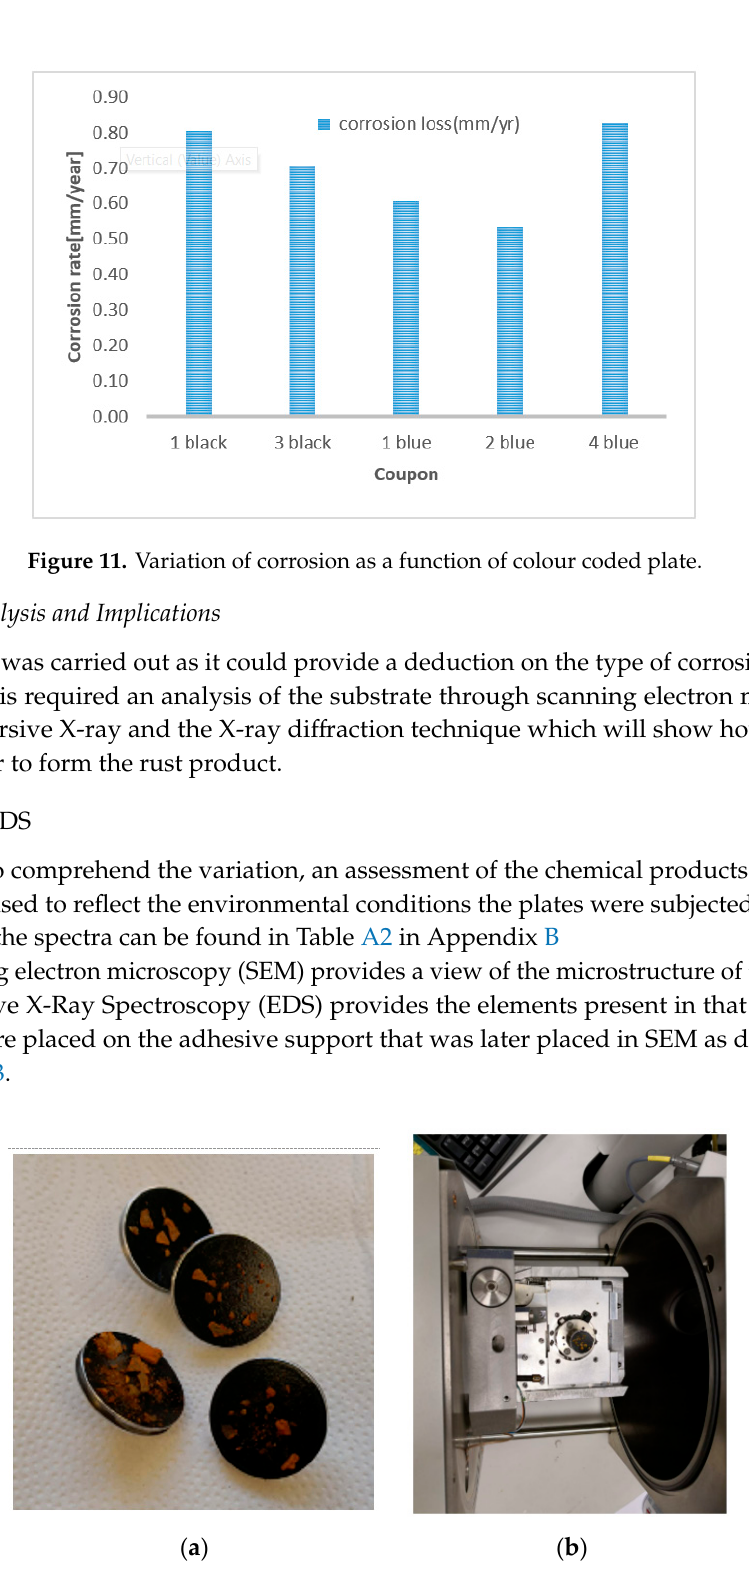
Figure 12. ( a ) Rust sample on sample holders, ( b ) Sample in vacuum chamber for SEM analysis.